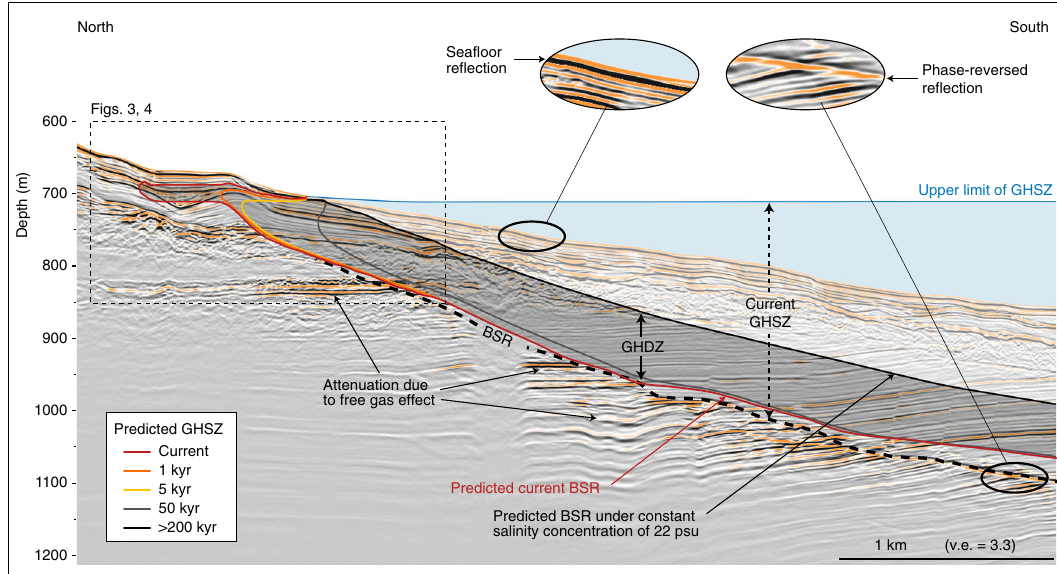
Fig. 2 Current GHSZ and its predicted evolution over time under salinization of sediment. The multi-channel HR seismic line (post-stack depth migrated section) is acquired in the region showing a clear BSR indicative of the base of the GHSZ. The BSR is characterized by a strong and negative polarity re fl ector (black circles) that behaves erratically with depth beneath sea fl oor < 750 mbsl. The seismic pro fi le is shown using the American convention where a decrease of impedance is represented by a negative re fl ection coef fi cient. To place fi rst-order constraints on the timing of methane hydrate dissociation along this line, we run a time dependent diffusive salinity forward model. The resulting calculations show evolution of the methane hydrate stability zone over time. The base of the current GHSZ will evolve with time to the black line corresponding to the predicted GHSZ under a constant salinity concentration of 22 psu according to simulation. Each colored line represents the transient location of the model-predicted GHSZ in the